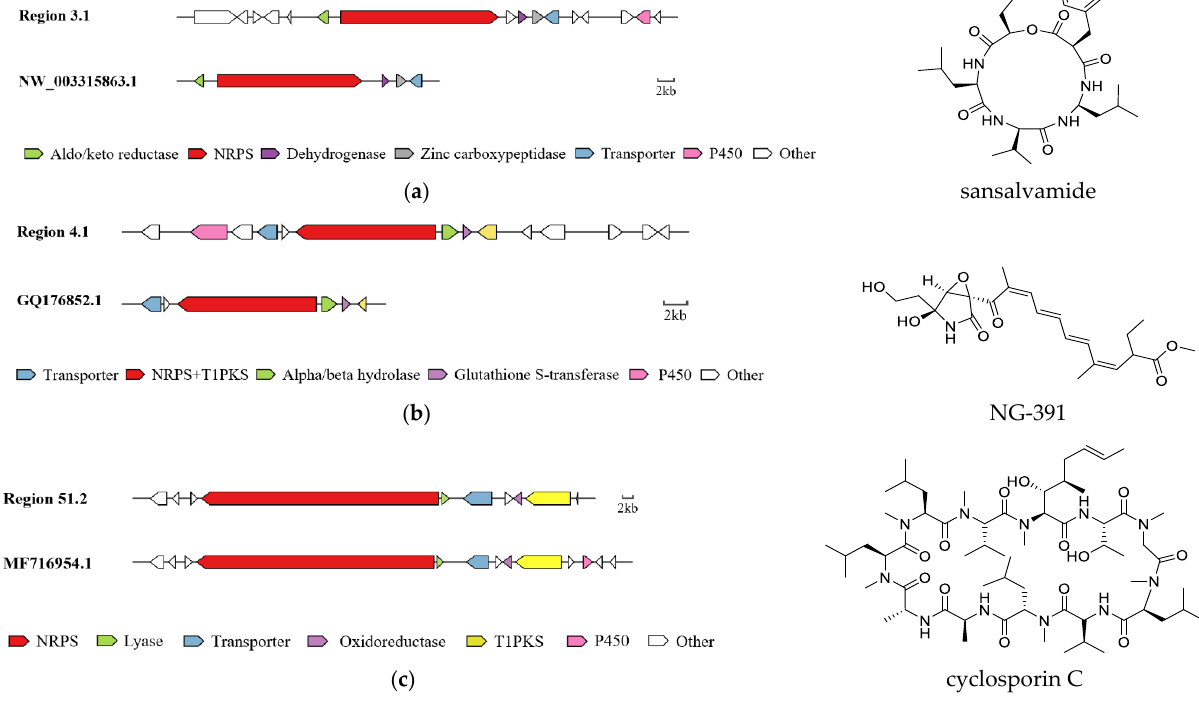
Figure 6. Comparison of BGC constituents in strain R1 with identified BGCs for biosynthesis of sansalvamide ( a ), NG-391 ( b ) and cyclosporin C ( c ). sansalvamide ( a ), NG-391 ( b ) and cyclosporin C ( c